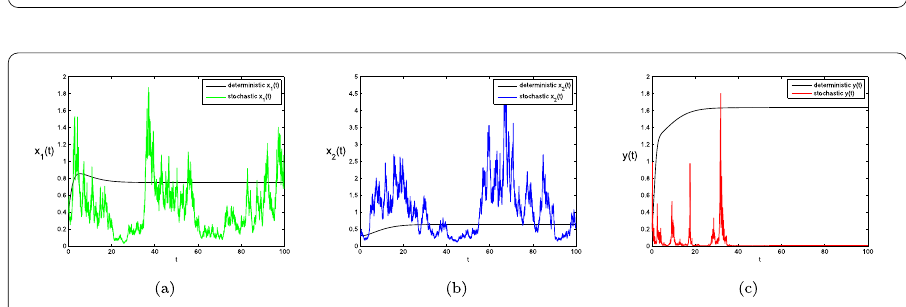
Figure 5 Solutions of stochastic system (3.1) with σ 1 = 1.5, σ 2 = 0.6, σ 3 = 1.7 show that all species go to extinct. ( a ) The solution of x 1 ( t ); ( b ) the solution of x 2 ( t ); ( c ) the solution of y ( t )